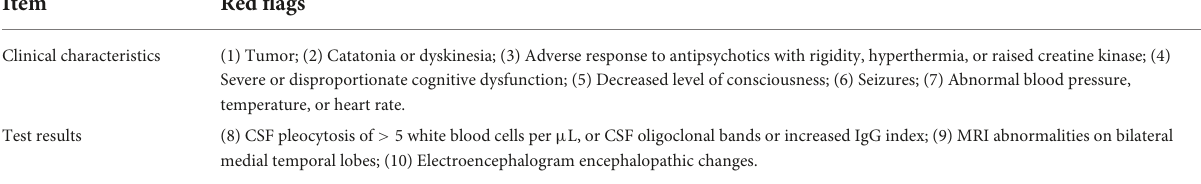
TABLE 1 Red flags for psychosis of suspected autoimmune origin. Red